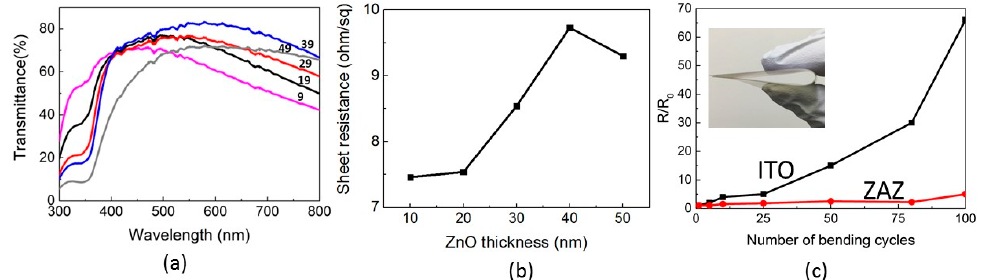
Figure 4. ( a ) Transmittance spectra of ZAZ electrodes with various thickness of ZnO layers from 9 to 49 nm. ( b ) Dependence of sheet resistance of the ZAZ electrode on ZnO thickness. ( c ) Flexibility test of the ITO and ZAZ electrode.